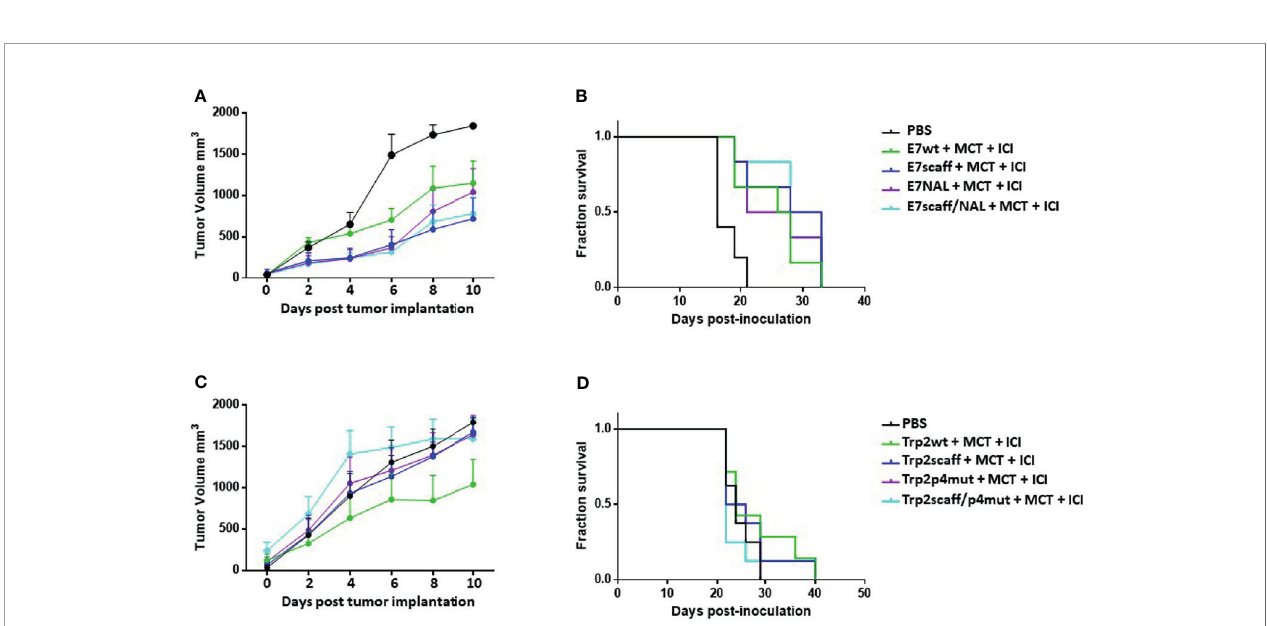
FIGURE 6 | Cancer vaccine ef fi cacy of scaffolds in therapeutic setting. C57BL/6 mice were administered with TC1 or B16F10 tumor cell lines. When palpable, indicated treatments were initiated. TC1 experimental model: (A) Tumor growth; (B) Keplein Mayer curve. B16F10 experimental model: (C) Tumor growth; (D) Keplein-Mayer